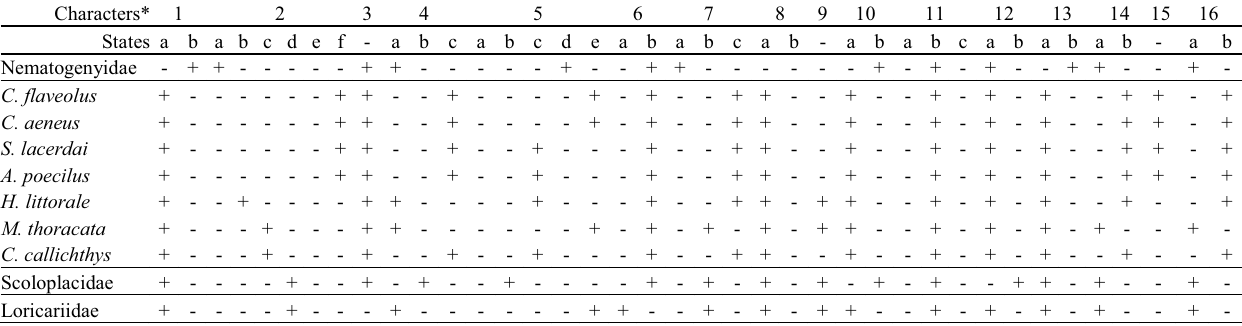
Table 2. Distribution of sperm character states in the species analyzed in the present study, as well as other families of Loricarioidea. (+) present; (-) absent. *1- flagella number (a- one; b- two); 2- arrangement of centriolar complex (a- lateral and parallel; b-lateral and acute angle; c- lateral and obtuse angle; d- anterior and perpendicular; e- anterior and obtuse angle; f- co-axial); 3- presence of elongated vesicles; 4- flagellar membrane specializations (a- absent; b- two lateral fins; c- membranous compartment); 5- shape of the nucleus (a- semi-ovoid; b- conic; c- ovoid; d-ovoid with its bigger axis in the horizontal direction; e- spherical); 6- pattern of chromatin condensation (a- heterogeneous; b- homogeneous); 7- nuclear fossa (a- absent; b- medial; c- eccentric); 8- nuclear fossa shape (a- simple arc; b- double arc); 9- centrioles totally inserted in the nuclear fossa; 10- midpiece size (a- short; b- long); 11- cytoplasmic channels (a- absent; b- one; c- two); 12- cytoplasmic channel size (a- short; b- long); 13- mitochondria shape (a- elongated; b- elongated and ramificated); 14- midpiece symmetry (a- symmetric; b- asymmetric); 15- Presence of electron-dense circular structure in the midpiece; 16- flagellum position in relation to the nucleus (a- medial; b-